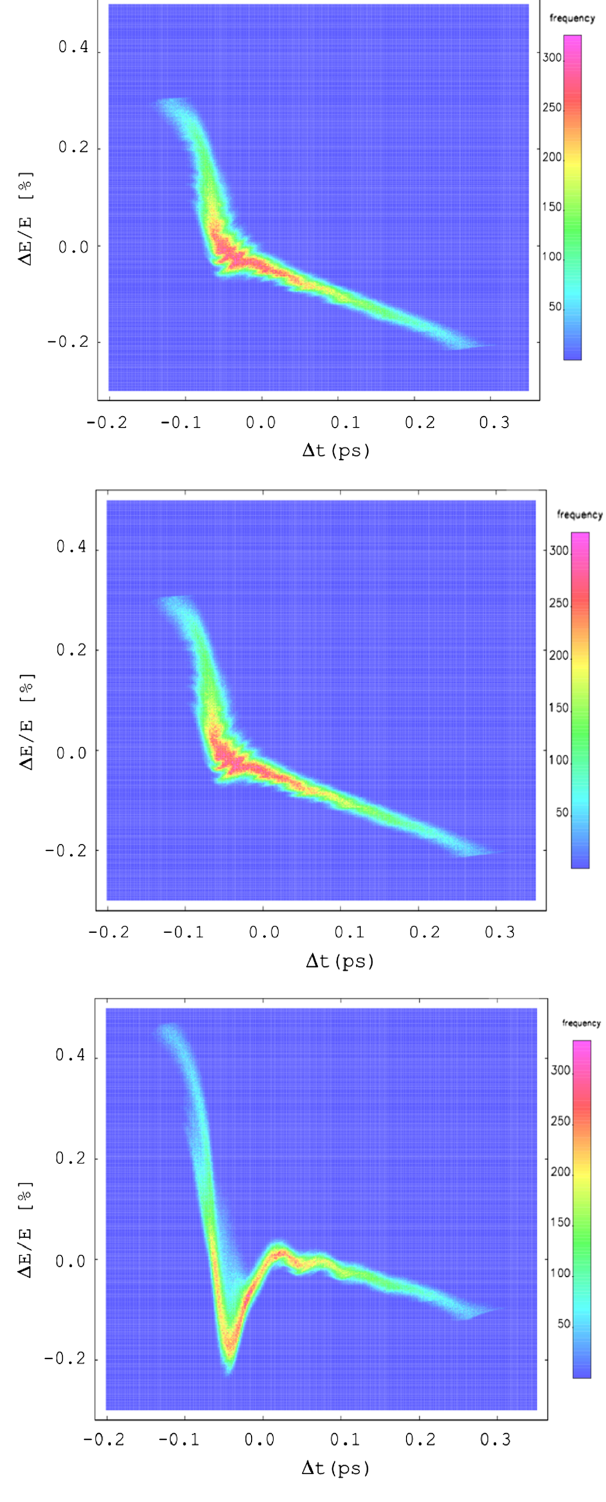
FIG. 10. From top to bottom: longitudinal phase space at the end of the CA (reference), at the end of the horizontal CA branch line, and at the exit of the vertical